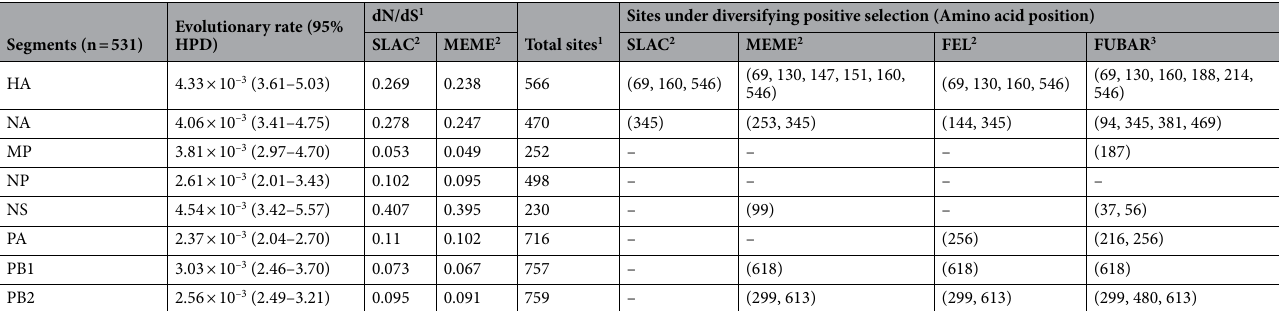
Table 2. Evolutionary rate of Bangladeshi H3N2 strains over a decade (Jan 2009–Dec 2020). HPD highest probability density, dN/dS ratio of non-synonymous and synonymous sites, SLAC single-likelihood ancestor counting, MEME mixed effects model of evolution, FEL fixed effects likelihood, FUBAR fast, unconstrained Bayesian approximation. 1 For MP and NS gene, respectively M1 and NS1 proteins were analyzed. 2 p-value threshold of 0.1. 3 Posterior probabilities of